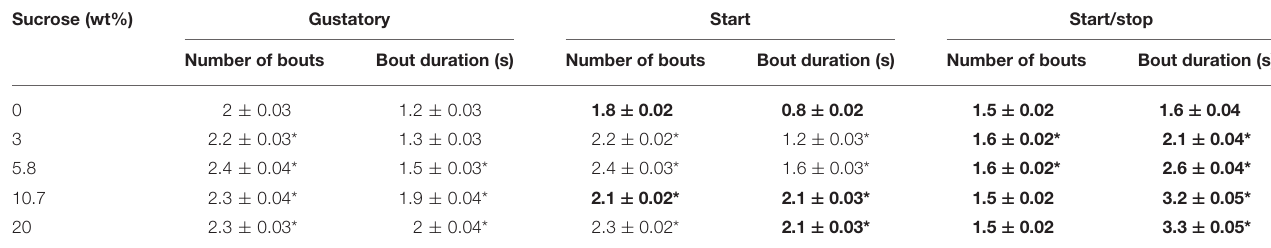
Values are mean ( ± sem). Data in bold means statistically different against the Gustatory task. * Indicates statistically different relative to water (0%). The alpha level was set at 0.05.